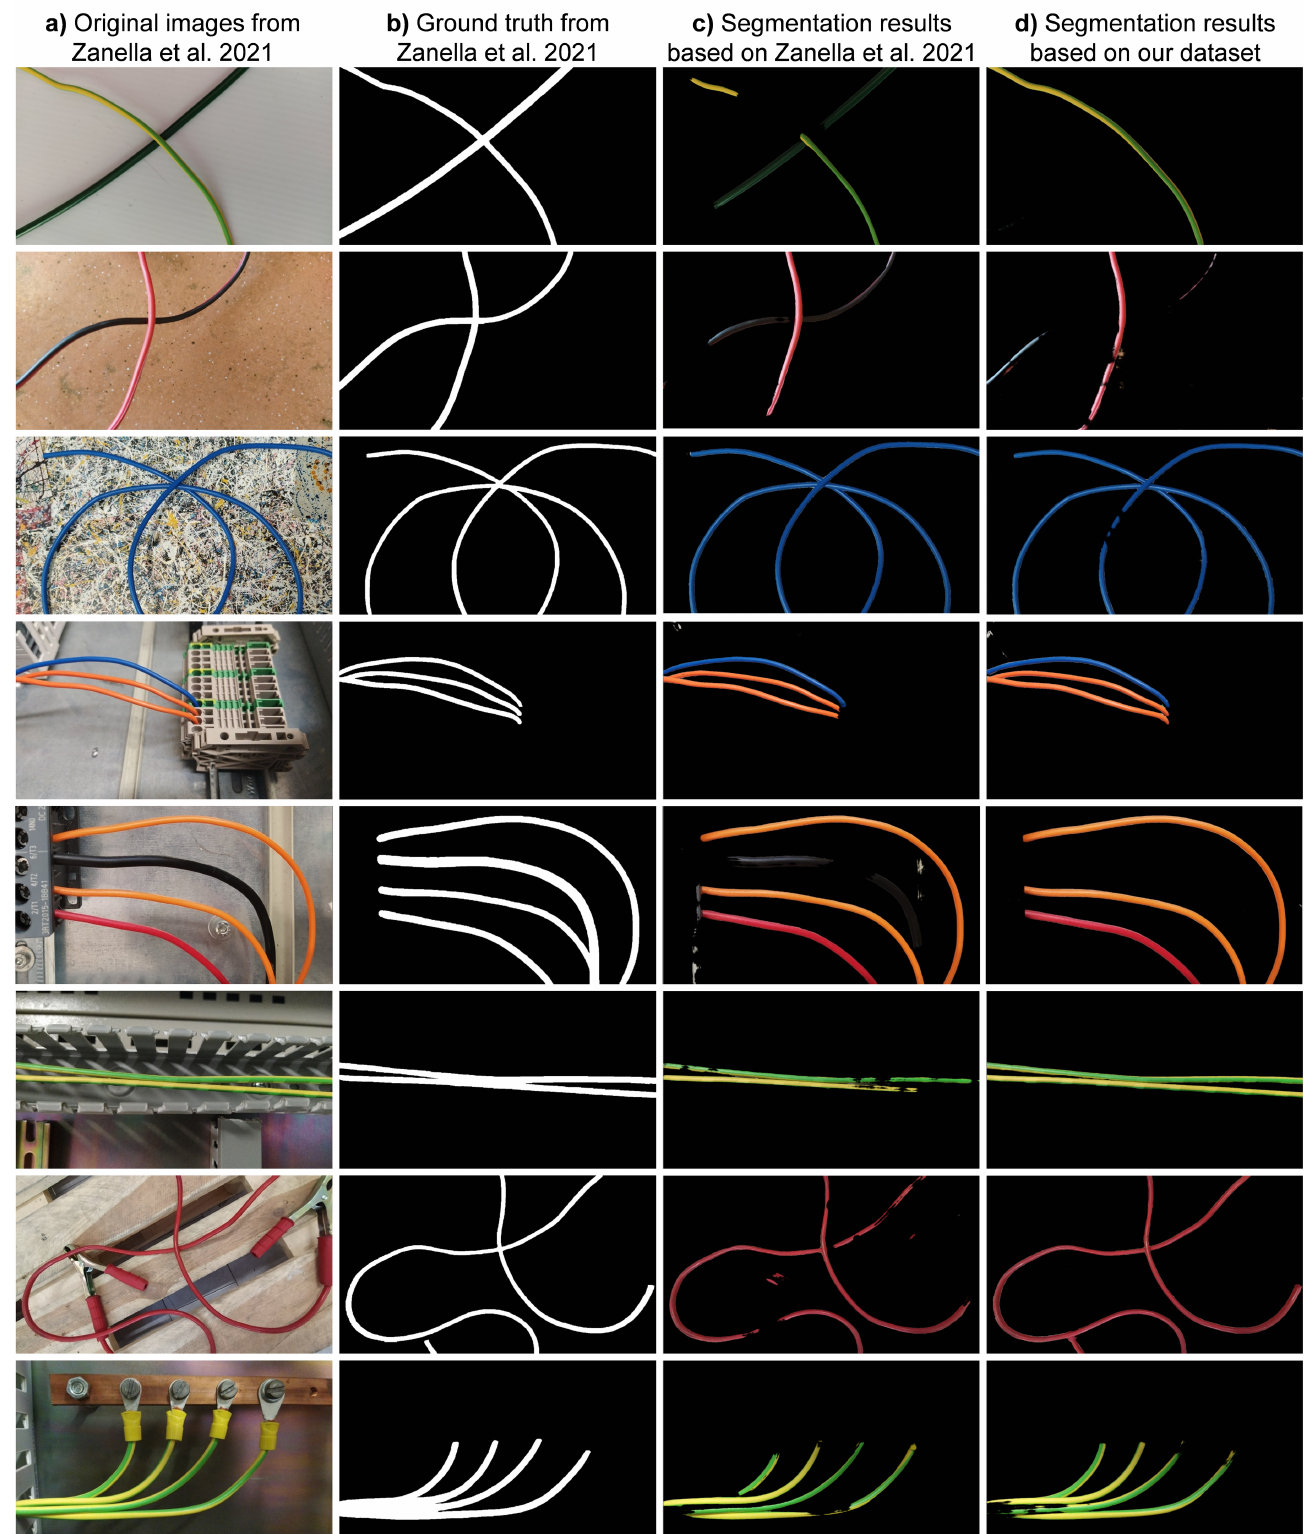
Figure A4. Semantic segmentation results for the electric cable benchmark: ( a ) Original images from [12], ( b ) ground truth segmentation masks from [12], ( c ) results based on the dataset of [12] and ( d ) results based on our